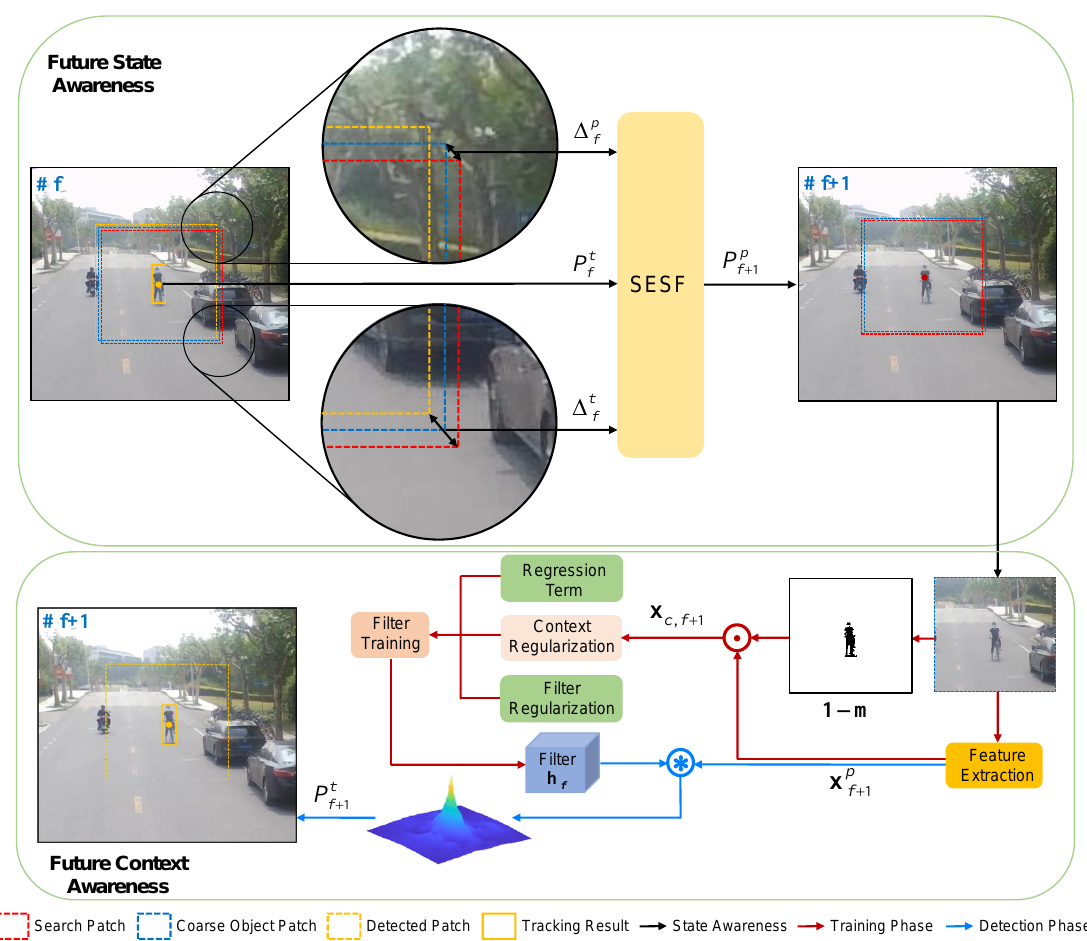
Figure 3. Tracking process of the proposed FACF tracker, which consists of two stages: future state awareness and future context awareness. Future state awareness: when a new frame is upcoming, we used the single exponential smoothing forecast to obtain a coarse target position. Future context awareness: we extract feature maps of the predicted region with the coarse position. Next, the feature maps are multiplied by the context mask to obtain the feature of the single context patch, which is then fed into filter training phase. Finally, the outputted filter performs target localization on the feature maps of the predicted